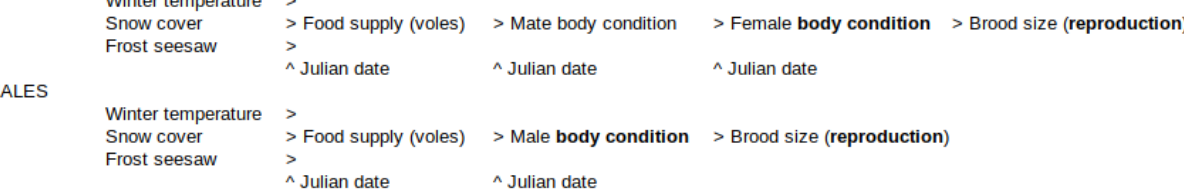
Figure 1. Path diagrams of the relationships of some extrinsic factors affecting body condition and reproduction in female and male Tawny Owls Strix aluco in southern Finland (see Section 2.3). The symbols > and ^ indicate the direction of the effect.